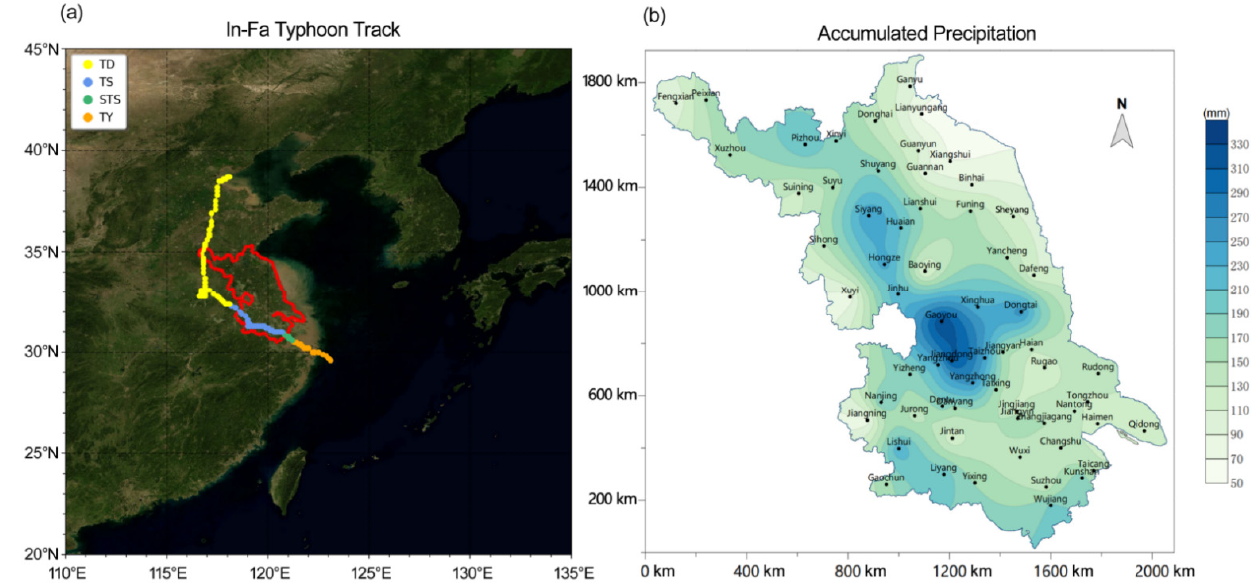
Figure 1. ( a ) Best track for Typhoon In-Fa (2021) based on observations from China Meteorological Administration (CMA), ( b ) Location of PARSIVEL disdrometer network (altogether 66 disdrometers) and accumulated precipitation (unit: mm) during the passage of Typhoon In-Fa from 25 July 0000UTC to 30 July 0000UTC. The superimposed red contour in panel ( a ) represents Jiangsu Province. Four categories of typhoon intensity are classified here following CMA, wherein TD represents tropical depression, TS represents tropical storm, STS represent super tropical storm, and TY represent typhoon.